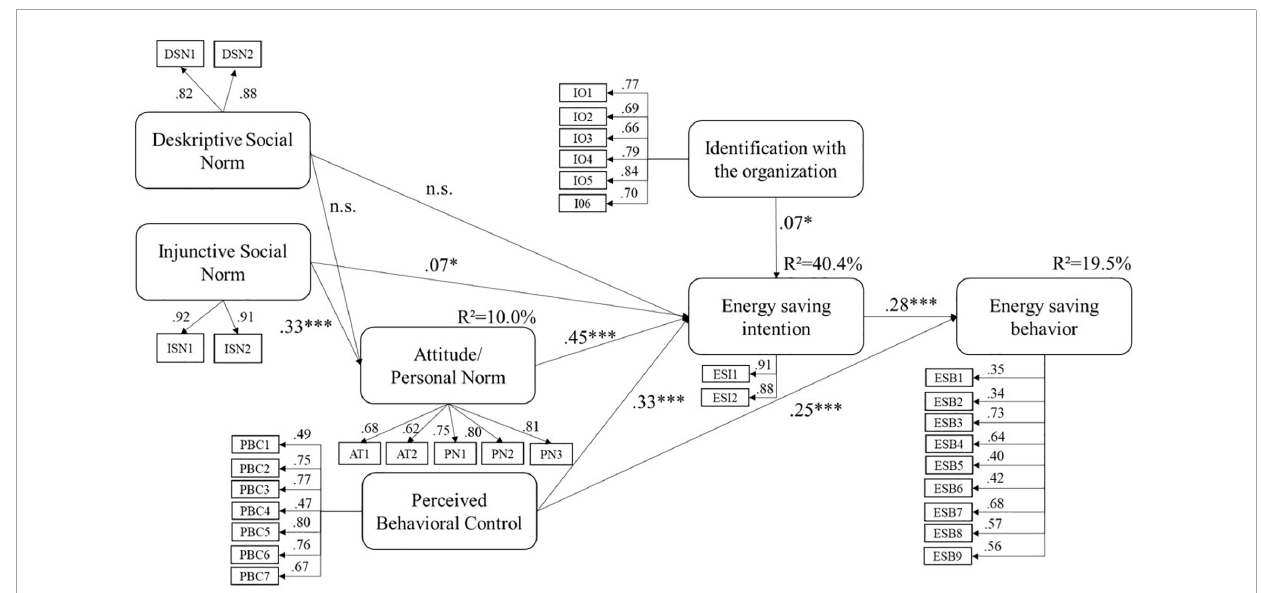
FIGURE2 Results of the structural equation modeling. Significance levels: ∗ p < 0.05, ∗∗∗ p < 0.001, n.s. not significant.